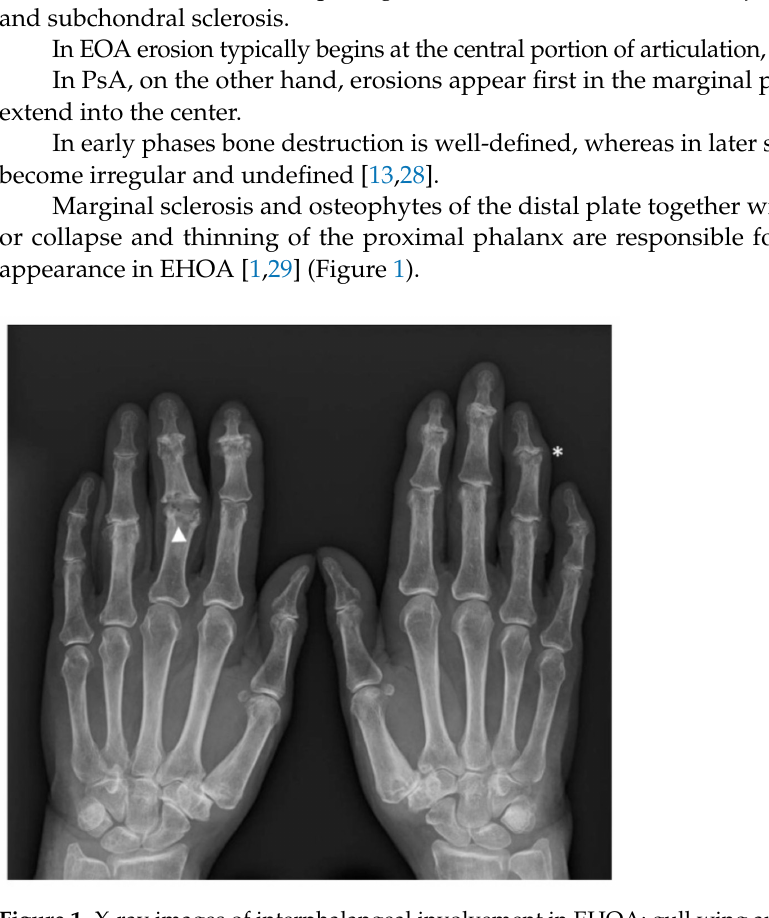
Figure 1. X-ray images of interphalangeal involvement in EHOA: gull wing appearance along with osteophytes and sclerosis (asterisk) and saw tooth appearance (triangle). Marginally located erosions in proximal subchondral cortex and marginal periostitis in the distal plate at DIP joints giving a characteristic appearance of “mouse ears” in PsA (Figure